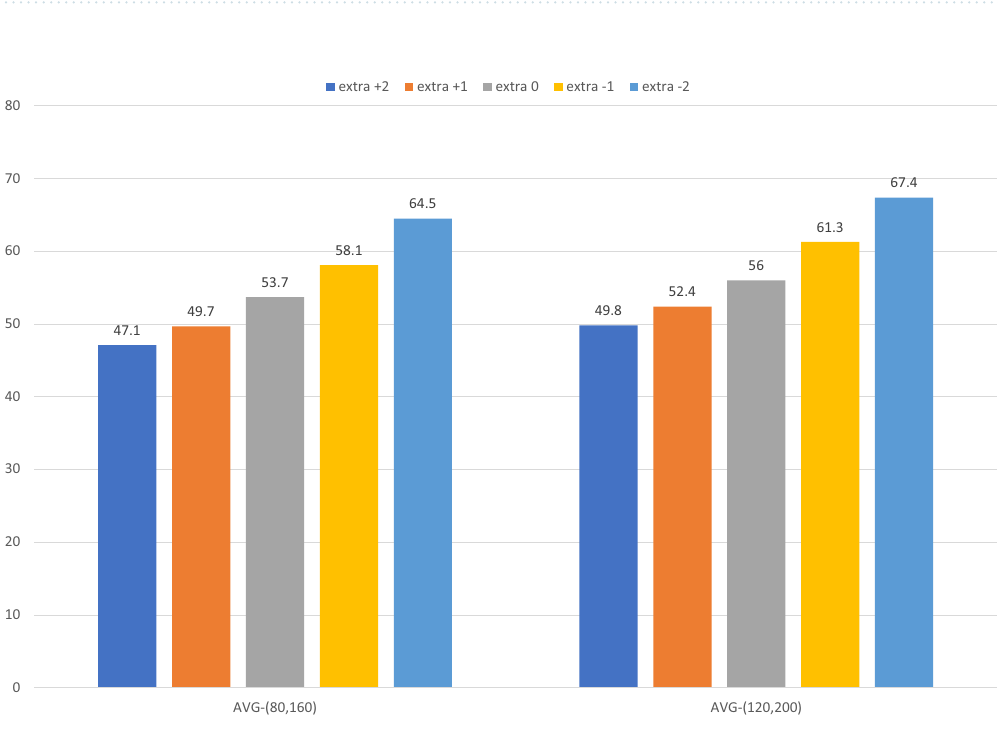
Figure 3. Realized objective value for 0, ±1, and ±2